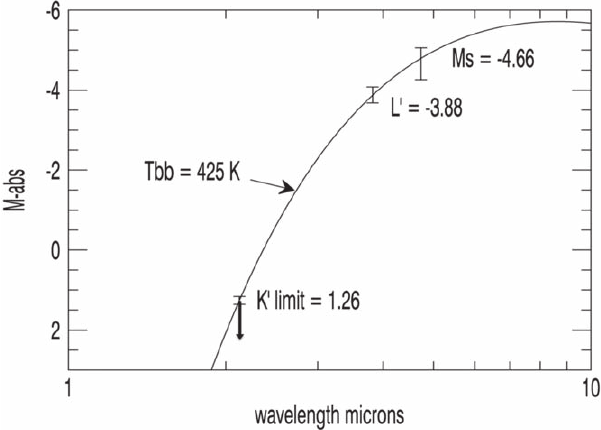
Figure 15. SED of X7 ʼ s tip. Fluxes measured at Kp ( upper limit ) , Lp , and Ms , plotted with an absolute magnitude scale. The overlaid curve is a 425 K blackbody pro fi le, which fi ts the measurements to within 50